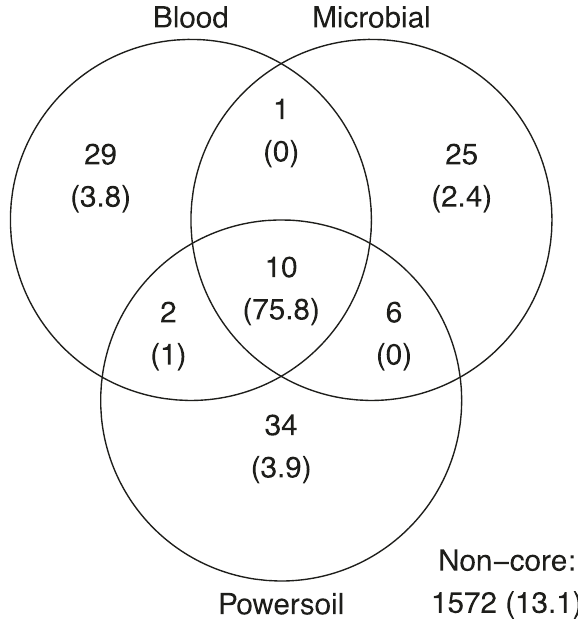
Fig. 4 Venn diagram of the core microbiota in the methodological controls. The numbers of OTUs with at least 0.001% of relative abundance in two of the fi ve control samples are displayed in each part of the diagram. The numbers in parentheses represent the sum of the average relative abundance of the OTUs in the controls. Therefore, they may not add up to 100% for each category. The non-core statistic represents the total relative abundance or number of OTUs observed in at least 0.001% relative abundance but that could not be found in at least two samples of the sample version of the